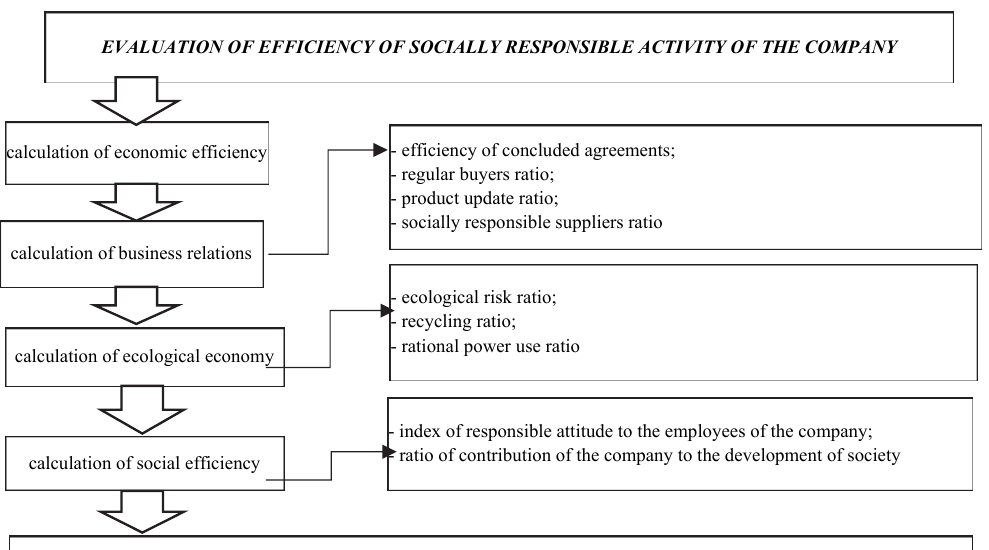
Fig. 1 Model of evaluation of efficiency of socially responsible